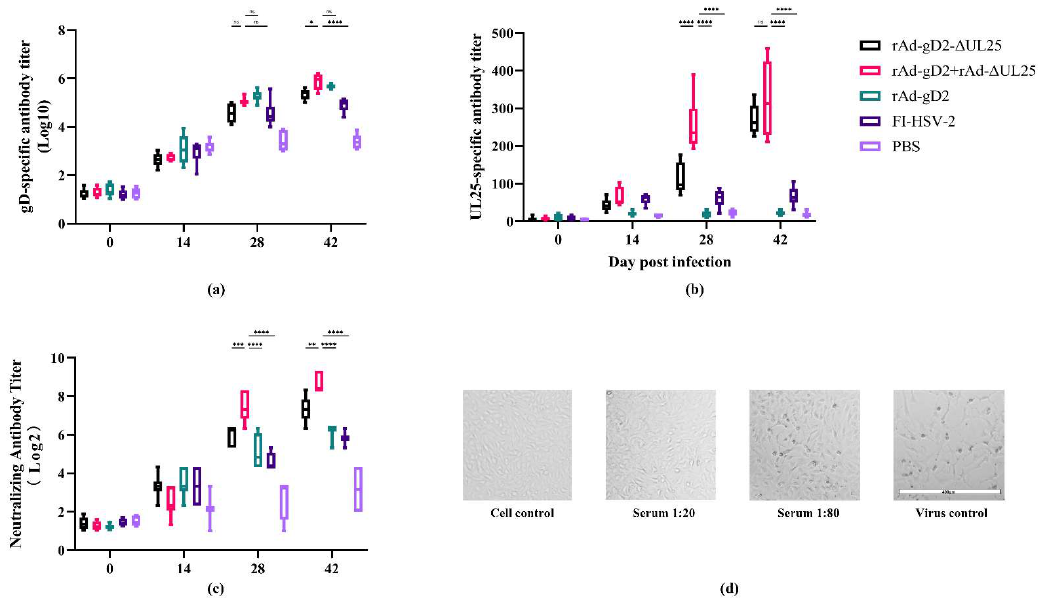
Figure 4. Antibody response to HSV-2-infected guinea pigs immunized with vaccines from different time points. ( a ) gD-specific antibody titer of guinea pigs was determined by direct ELISA. Y -axis shows IgG antibody titers in the log10 scale. rAd-gD2 + rAd- ∆ UL25 was the highest in gD-specific antibody titer compared with rAd-gD2 ∆ UL25 and rAd-gD2. Because of the challenge, the PBS control group also developed a detectable gD-specific antibody, while all the other groups were significantly higher than PBS. ( b ) UL25-specific antibody titer of guinea pigs was determined by direct ELISA. Y -axis shows UL25-specific antibody titers. rAd-gD2 + rAd- ∆ UL25 was the highest in gD-specific antibody titer and was non-significant (ns) with rAd-gD2 ∆ UL25. ( c ) Neutralizing antibody titer of guinea pigs was defined as the reciprocal value of the highest serum dilution for which no CPEs were detected. Y -axis shows neutralizing antibody titers in the log2 scale. rAd-gD2 + rAd- ∆ UL25 was the highest in neutralizing antibody titer, approximately 3.5 times higher than rAd-gD2 ∆ UL25. All the immunized groups were significantly higher than PBS. **** p < 0.0001; *** p < 0.001; ** p < 0.01; * p < 0.05; ns, not statistically significant. ( d ) Images of CPE with different serum dilutions in rAd-gD2 + rAd- ∆ UL25 (42